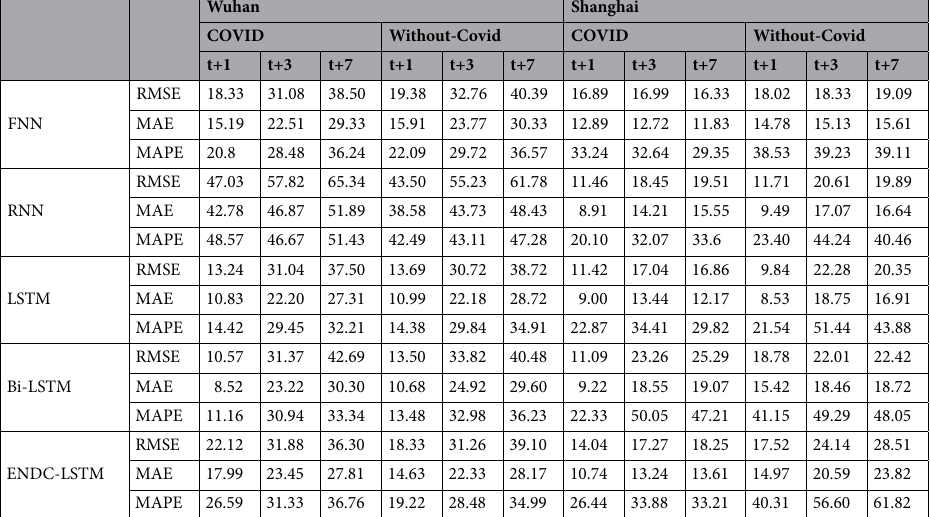
Table 4. The impacts of COVID-19 on the different model in Wuhan.